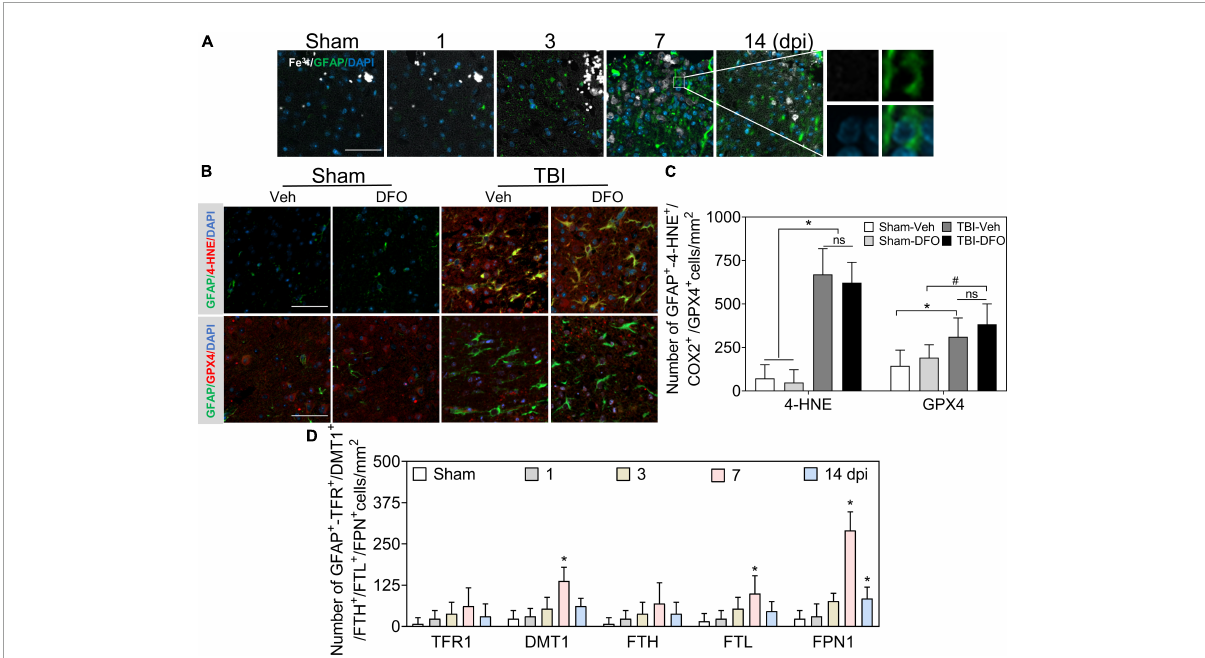
FIGURE3 Oxidative stress in astrocytes is irregulated to intracellular iron after TBI. (A) Representative colocation image of Fe 3 + and GFAP in ipsilateral cortices at the indicated time after TBI. ( n = 6, scale bar = 50 µ m). (B) Representative colocation image of 4-HNE and GPX4 with GFAP in injured cortices of mice after 7 days treatment of Veh or DFO ( n = 3, scale bar = 50 µ m). (C) Quantitative analysis of the number 4-HNE/GPX4-GFAP-positive cells. Interestingly, iron was not detected in astrocytes, while oxidative damage was severe, which could not be ameliorated by DFO. * p < 0.05 versus the Sham-Veh or Sham-DFO group, # p < 0.05 vesus the Sham-DFO group. (D) Quantitative analysis of the number of TFR1/DMT1/FTH/FTL/FPN1-GFAP-positive cells in injured cortices at the indicated time dpi. Data are presented as mean ± SD, and n = 6. * p < 0.05 versus the Sham group. TBI, traumatic brain injury; GFAP, glial fibrillary acidic protein; 4-HNE, 4-hydroxynonenal; GPX4, glutathione peroxidase 4; DFO, deferoxamine; Veh, traumatic brain injury + vehicle; dpi, days post-injury; TFR1, transferrin R1; DMT1, divalent metal transporter 1; FTH, ferritin heavy chain; FTL, ferritin light chain; FPN1,